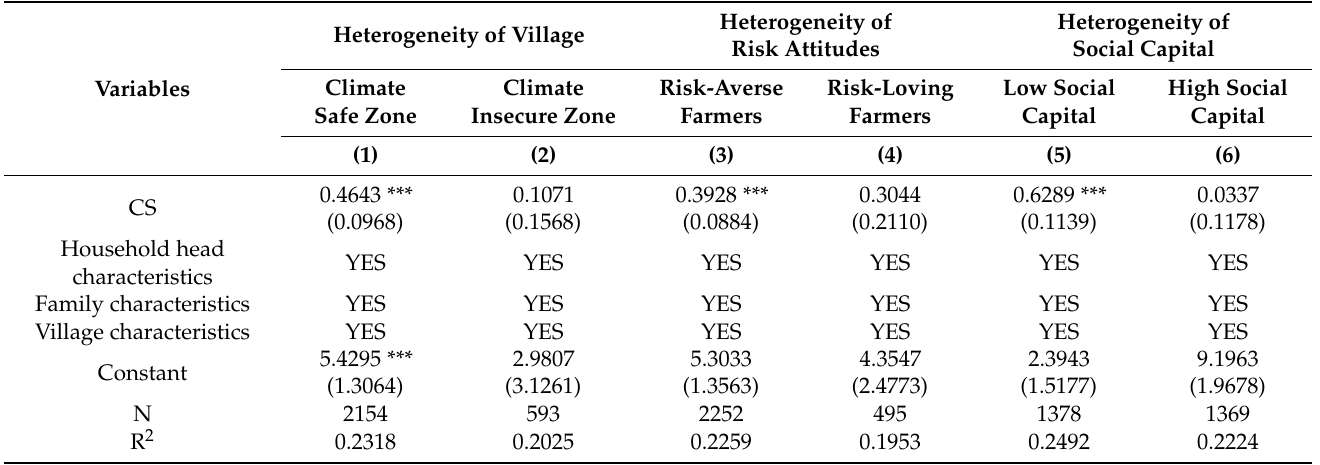
Table 5. The results of heterogeneity